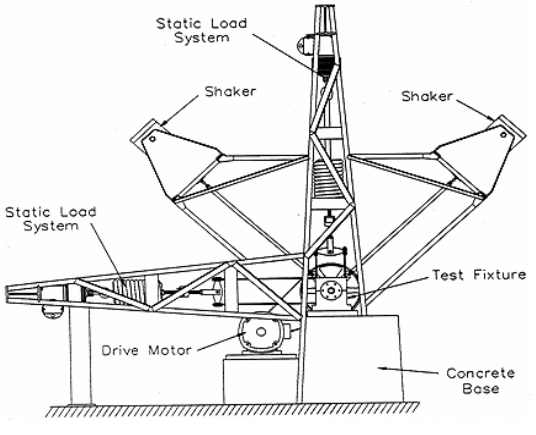
Fig. 4. Flack et al. [68] test